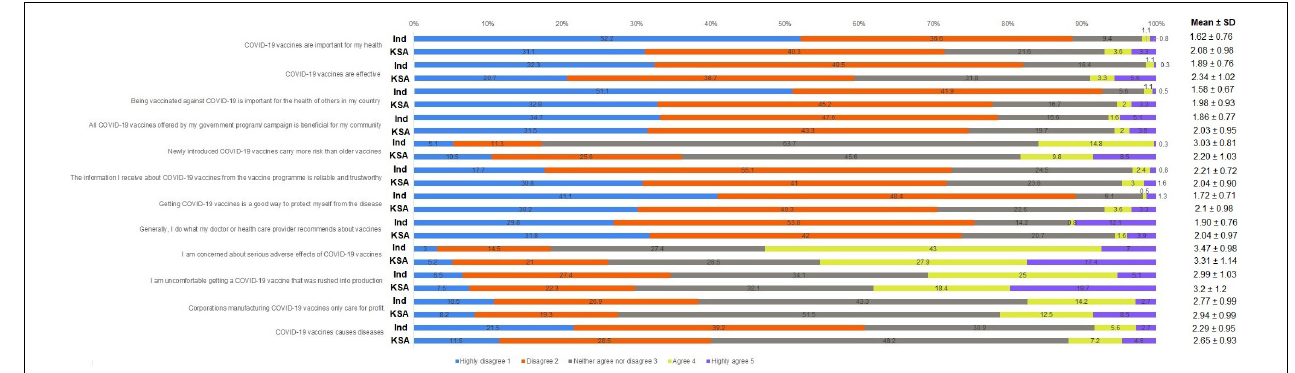
FIGURE 2 | Distribution of responses for each of the 12 items of COVID-19 vaccine hesitancy Scale (in %) with Mean and Standard deviation score of each item in India and Saudi Arabia. Questions 5, 9, 10, 11 and 12 were coded with 1–highly disagree to 5–highly agree. Questions 1, 2, 3, 4, 6, 7 and 8 were reverse coded with 1–highly agree and 5–highly disagree, Ind, India; KSA, Kingdom of Saudi Arabia.